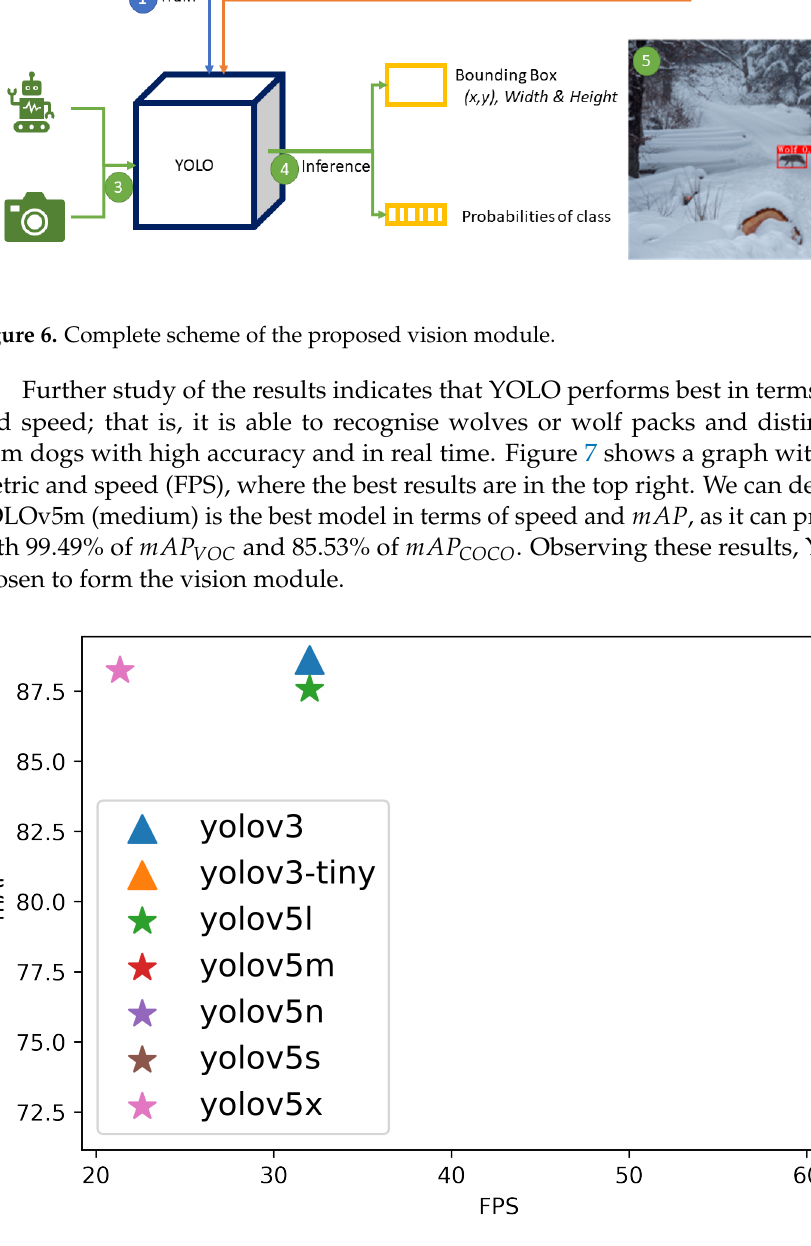
Figure 7. Results of the mAP COCO over the speed for YOLO